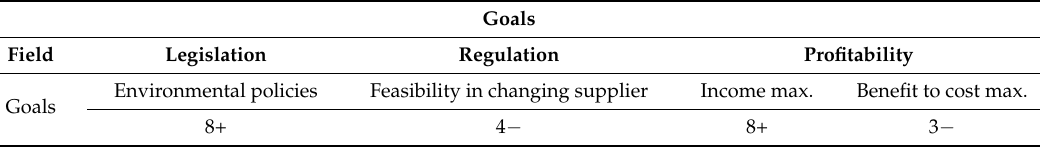
Table 3. Goals of the future electricity market key players in Europe.